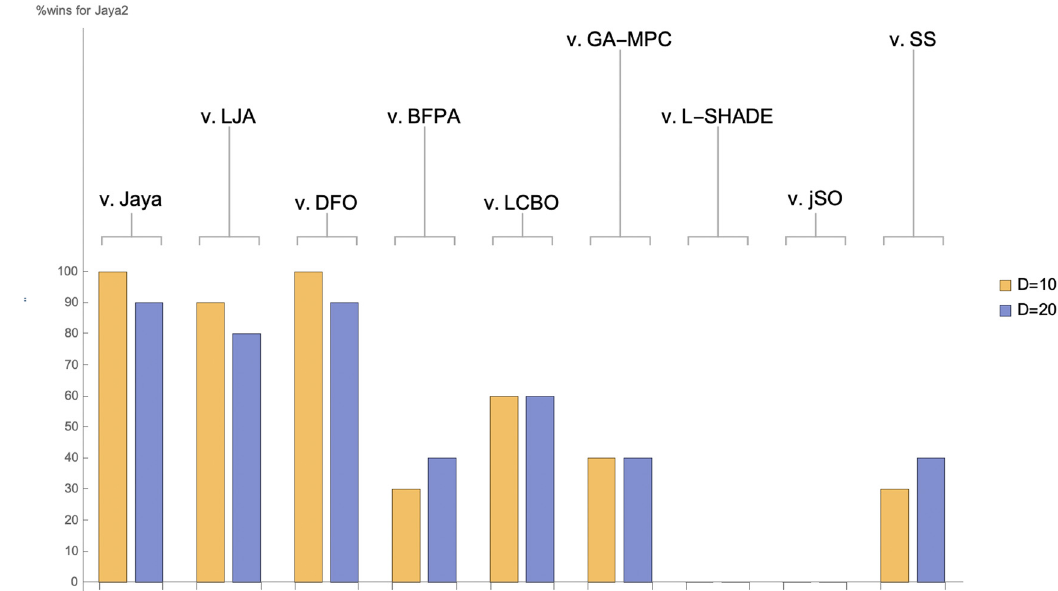
Figure 8: The percentage of wins for Jaya2 vs the other competing